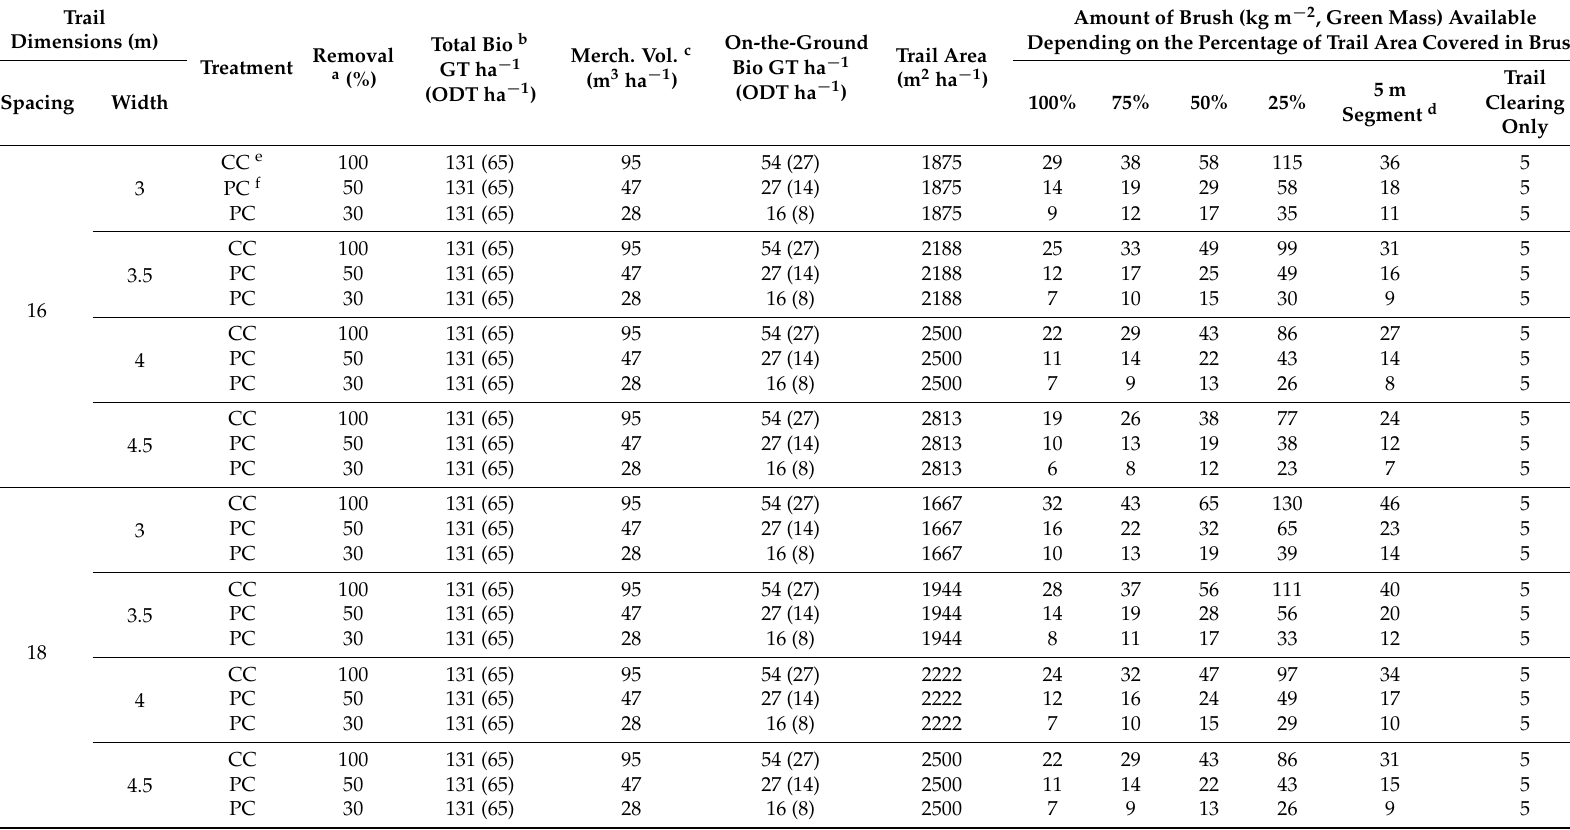
Table A1. Amount of brush available for soil protection as brush mats depending on silvicultural treatment, trail spacing, trail width and varying trail coverage obtained from a naturally regenerated softwood stand